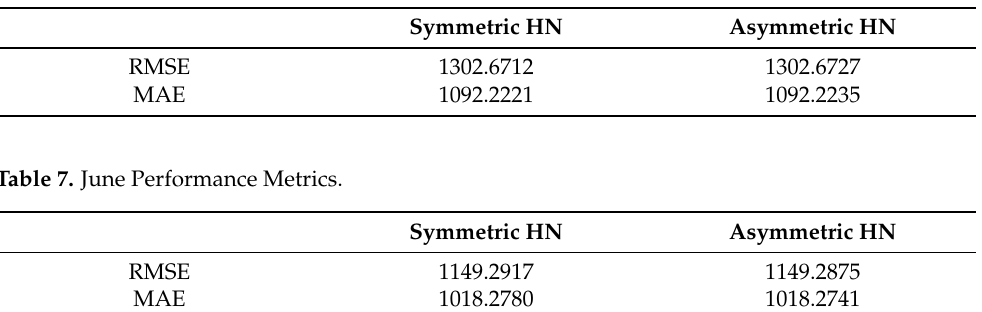
Table 6. May Performance Metrics.